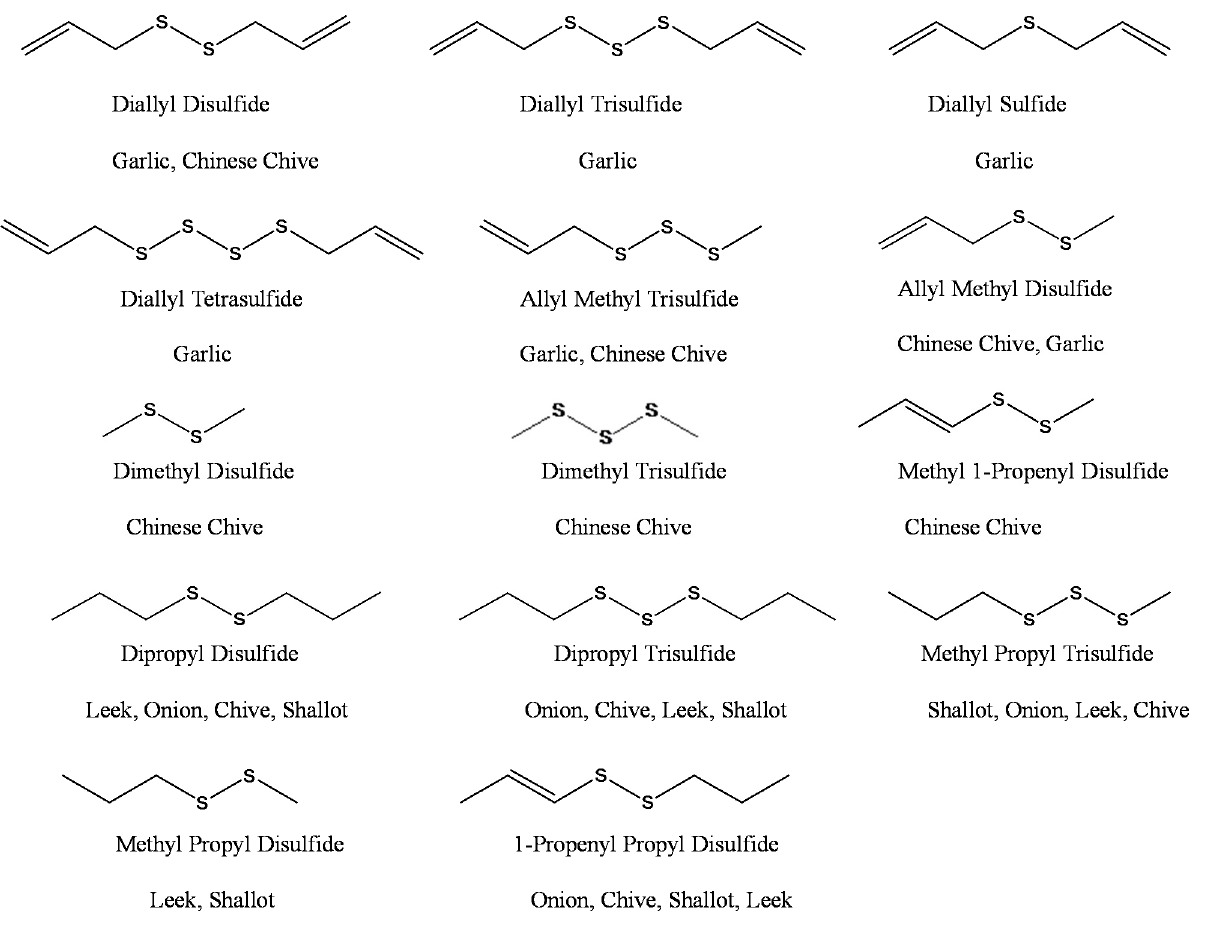
Figure 1. Structure of major compounds of the essential oils of garlic, onion, leek, Chinese chive, shallot and